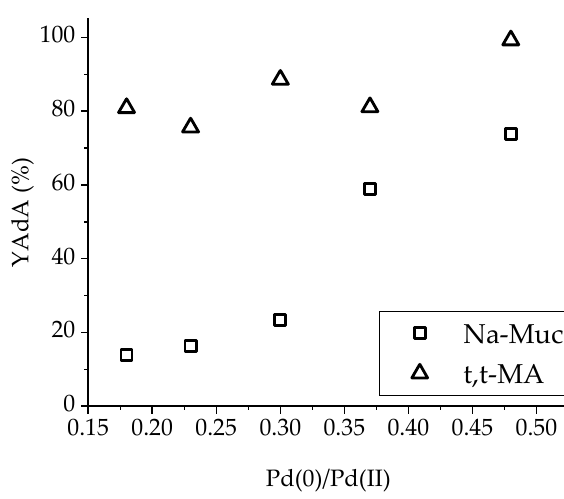
Figure 9. YAdA after 30 min in function of Pd(0)/Pd(II) ratio.